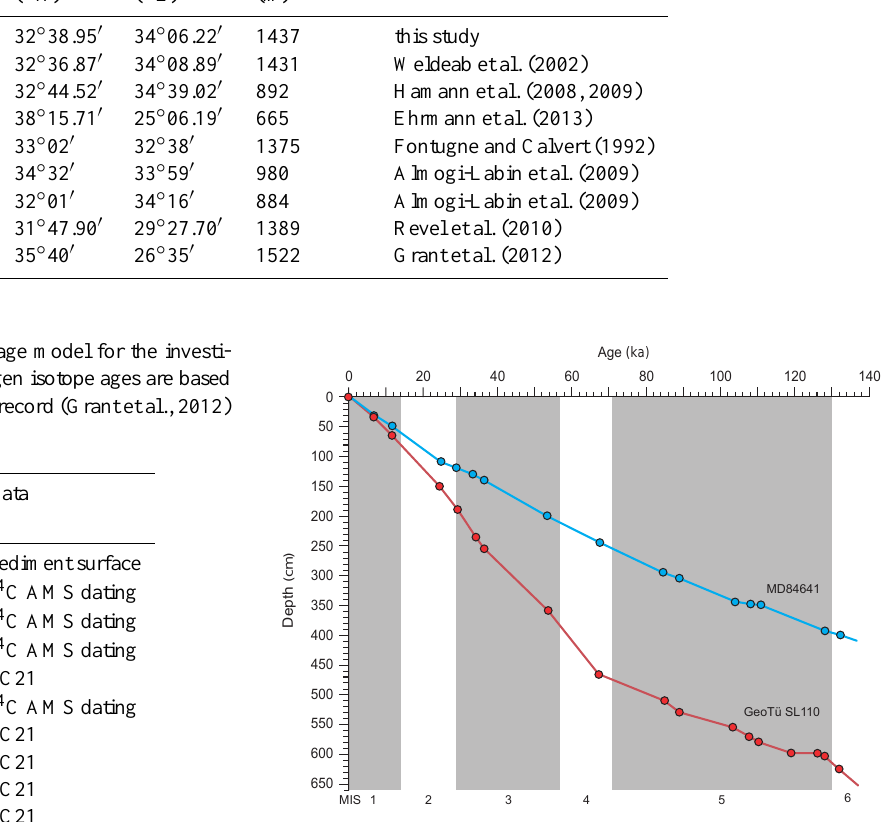
Figure 2. Depth–age plot for the investigated sediment core GeoTü SL110 (red). The age points are listed in Table 2. For compari- son, corresponding data were extracted for core MD84-641 (blue; Fontugne and Calvert, 1992: Table 1). Marine isotope stages (MISs) follow Lisiecki and Raymo